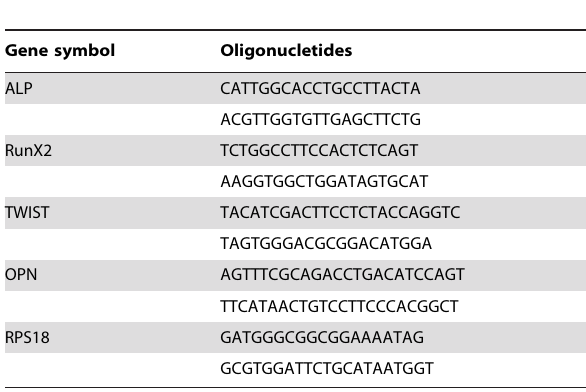
Table 1. Primers sequences designed for real time RT- polymerase chain (PCR)